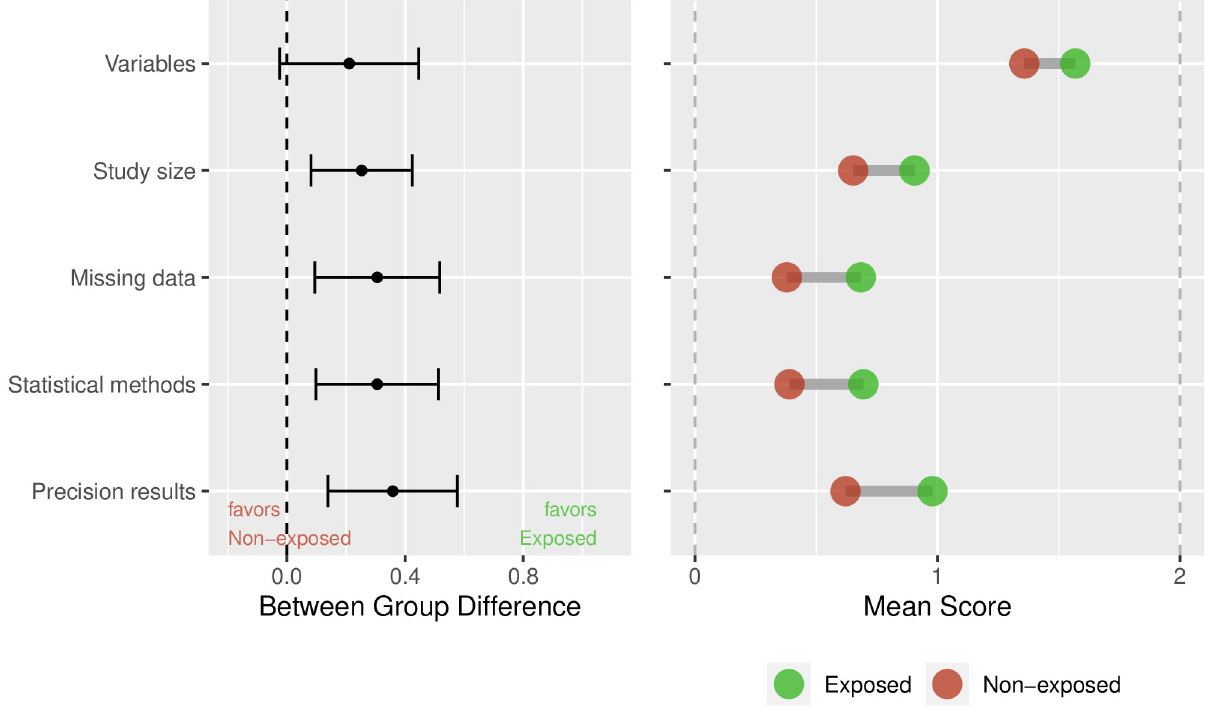
Fig 3. Estimated between-group difference per dimension with 95%CI (left); raw means in exposed and non-exposed publications (right). Unit of analysis is dimension.